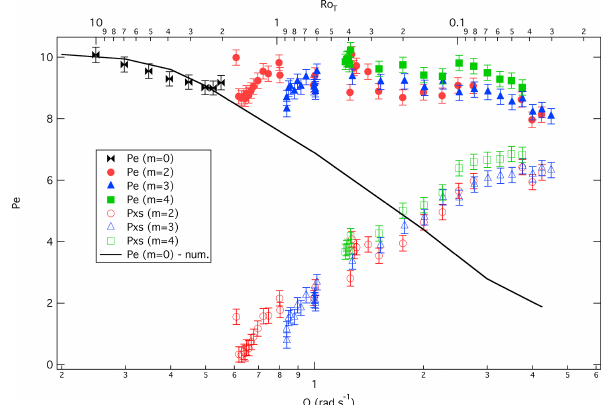
Figure 8. Variations of radial heat transport by baroclinic eddies and axisymmetric flows in a differentially heated rotating annulus, as measured in the laboratory (Read, 2003) as a function of ro- tation rate and the thermal Rossby number Ro T . The total advec- tive heat transport is indicated by the dimensionless Péclet number ( Pe = Nu − 1, where Nu is Nusselt number; see Eq. 12). Solid sym- bols represent total heat transport as measured by calorimetry, while the continuous line represents the total heat transport by the axisym- metric flow alone. Open symbols indicate the difference, Pxs, in Pe between measured total advective heat transport and the axisymmet- ric component, representing the heat transport due to eddies alone of dominant azimuthal wavenumber m . Numerical simulation: